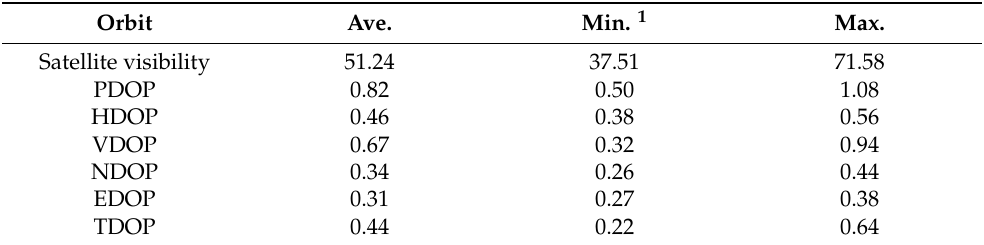
Table 8. Statistical results of satellite visibility, PDOP, HDOP, VDOP, and TDOP of the